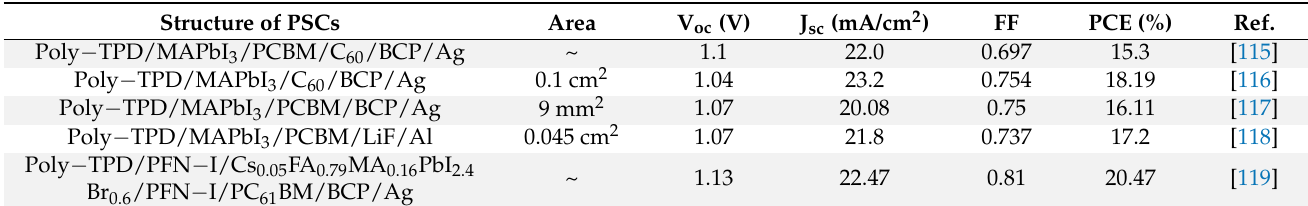
Table 9. Performances of several representative inverted PSCs on the basis of the different Poly − TPD HTL